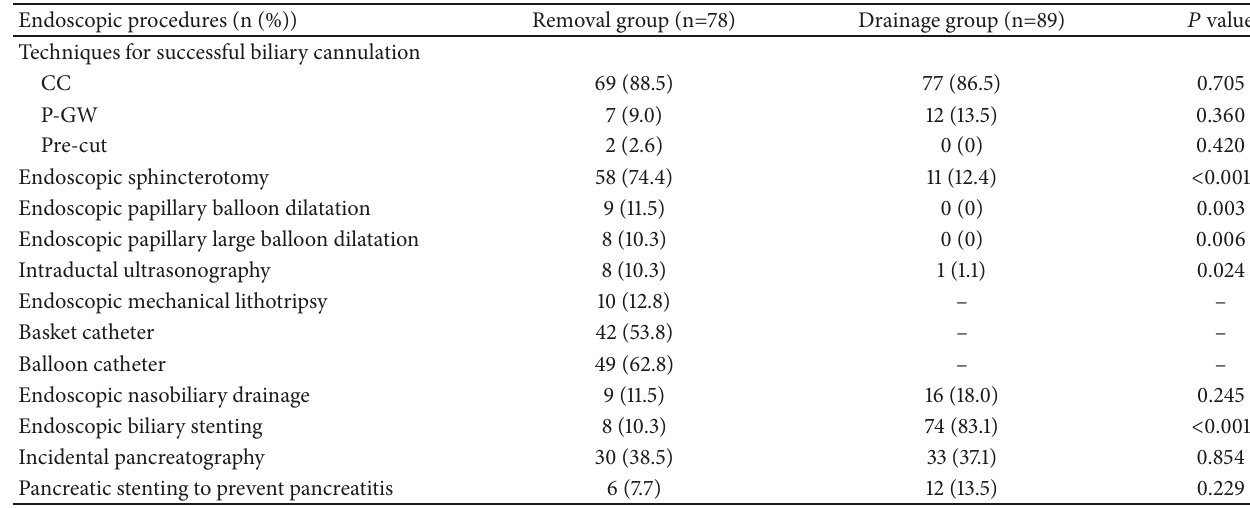
Table 2: Procedures of early endoscopic retrograde